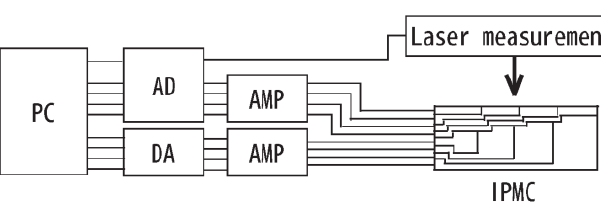
Figure 5. Experimental